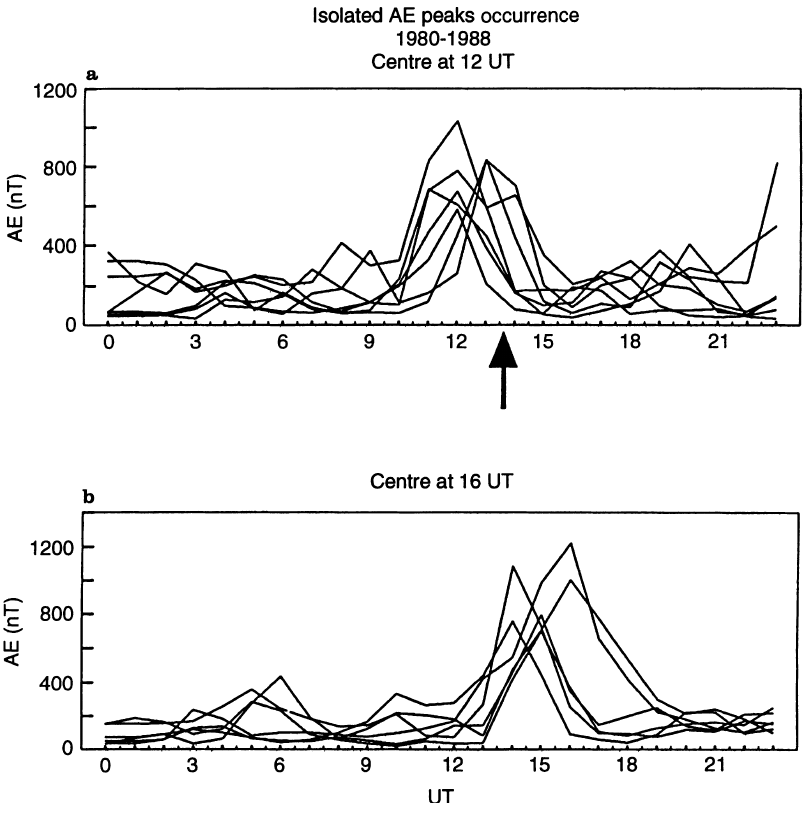
Fig. 1a,b. Examples of preferred occurrence times of some isolated substorm onsets at 1980– 1988, as inferred from the hourly AE-indices. The mean midnight of the Eastern Siberia- Japan-Eastern Australia (sector 1) is indicated by the arrow (repeated on